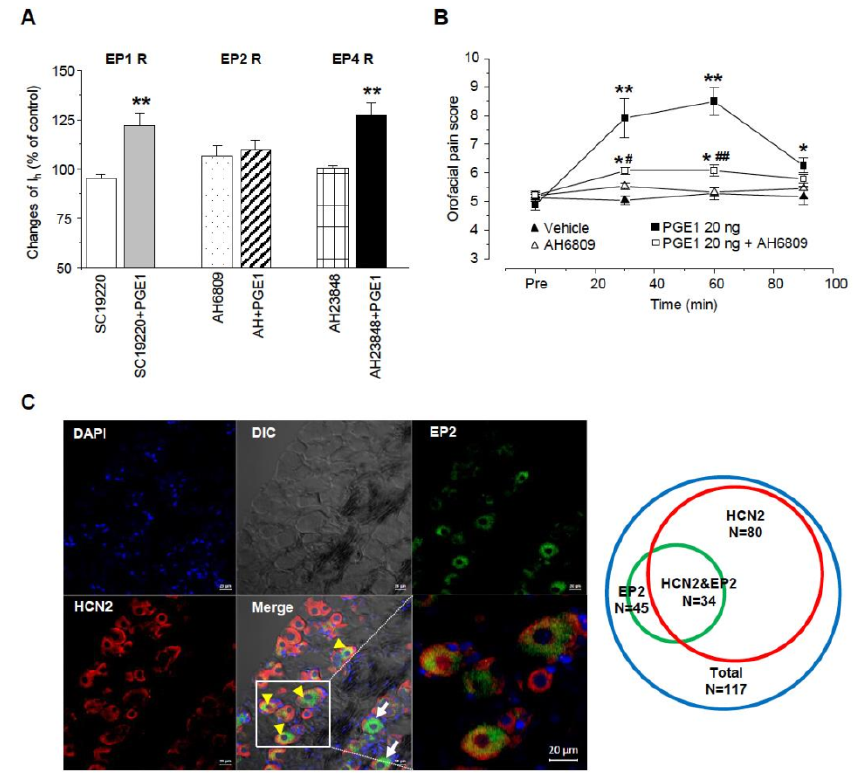
Figure 6. E-type prostaglandin (EP)-receptor of PGE1 for facilitation of I h . ( A ) Summary for the effects of PGE1 on I h current in the presence of each EP receptor (EP1, EP2, and EP4) antagonist. EP2 receptor antagonist (AH6809, 10 µ M) inhibited the facilitation of I h by PGE1 (100 nM). SC19220: EP1 receptor antagonist, AH6809: EP2 receptor antagonist, AH23848: EP4 receptor antagonist. (** p < 0.001, paired t-test) ( B ) The orofacial pain score from a representative pain behavior for 90 min after the application of the vehicle, PGE1 (20 ng/10 µ L), and a combination of PGE1 and AH6809 (10 µ g/10 µ L) into the whisker pad of mice. Results are presented as the mean ± SEM (* p < 0.05. ** p < 0.001 compared to the vehicle group; # p < 0.05. ## p < 0.001 compared to the PGE1 group, one-way ANOVA). ( C ) Left: Double immunostaining of EP2 with HCN2 channels in TG neurons. DAPI was used as tissue counterstaining. In TG, EP2 was present as the green color and HCN2 channels were present as red color on different interference contrast (DIC) images. Yellow arrowhead co-expression of EP2 and HCN2, arrow; expression of EP2, Bar = 20 µ m. Right: Diagram of TG neuron population expressing HCN2 and EP2. Total TG neurons were represented by blue circle (n = 117), EP2 by green circle (n = 45), and HCN2 by red circle (n = 80), respectively. HCN2&EP2 refers to TG neurons (n = 34) in which both HCN2 and EP2 are